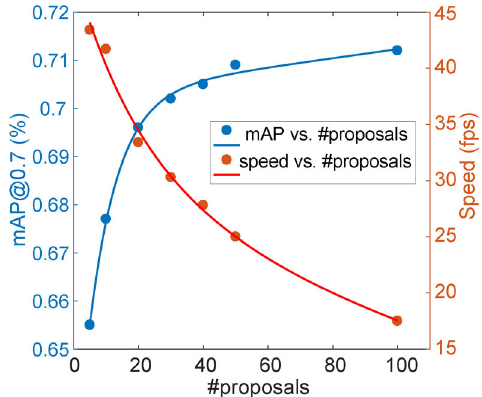
Fig. 8 With increasing proposals, S4Net performs better, but the time taken increases in parallel.